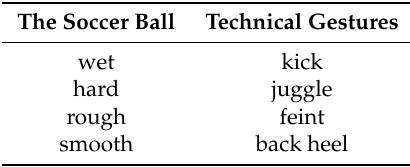
Table 1. The relevant game